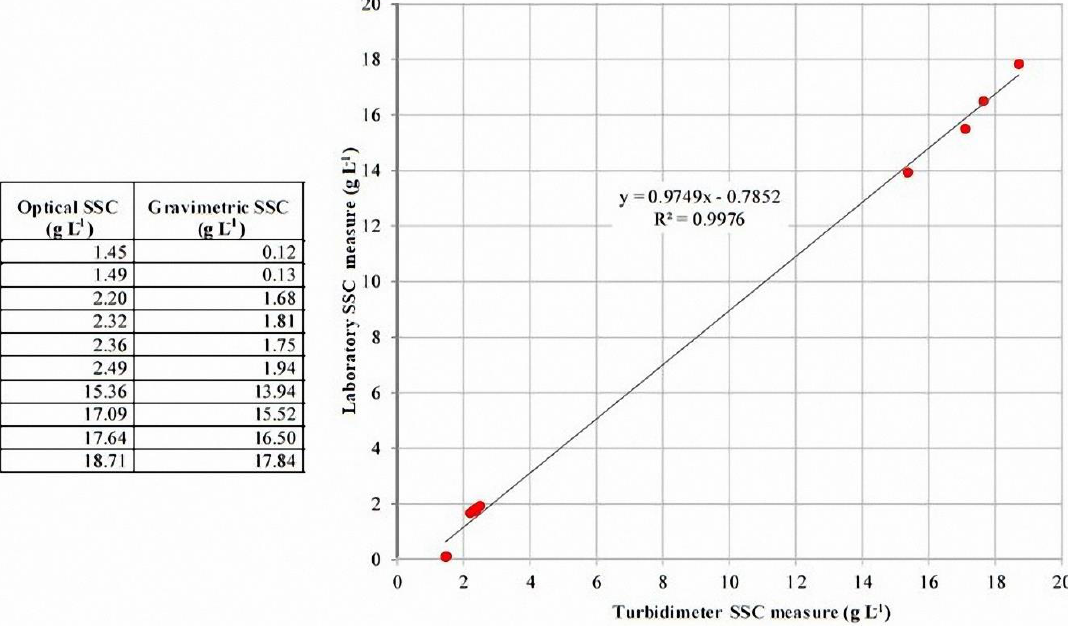
Figure 5. Data for probe calibration, comparison of optical and gravimetrical measurements in g L −1 .